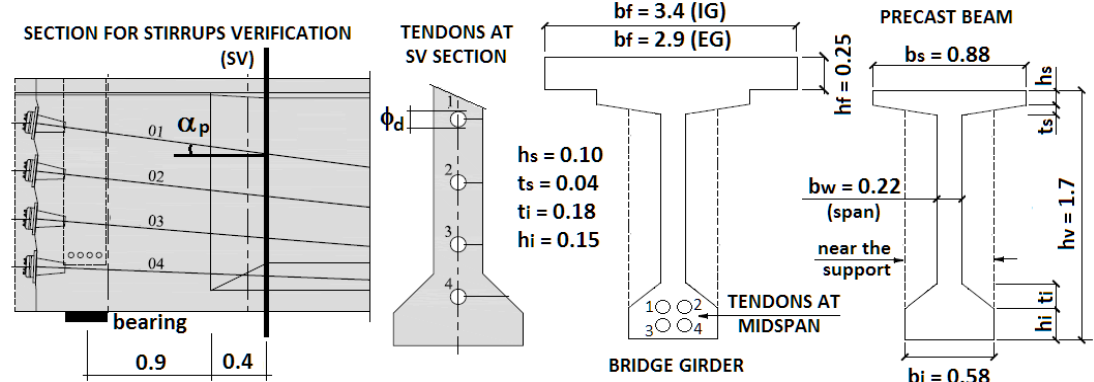
Figure 10. Bridge girder details, dimensions in meters (EG: exterior girder; IG: interior girder).